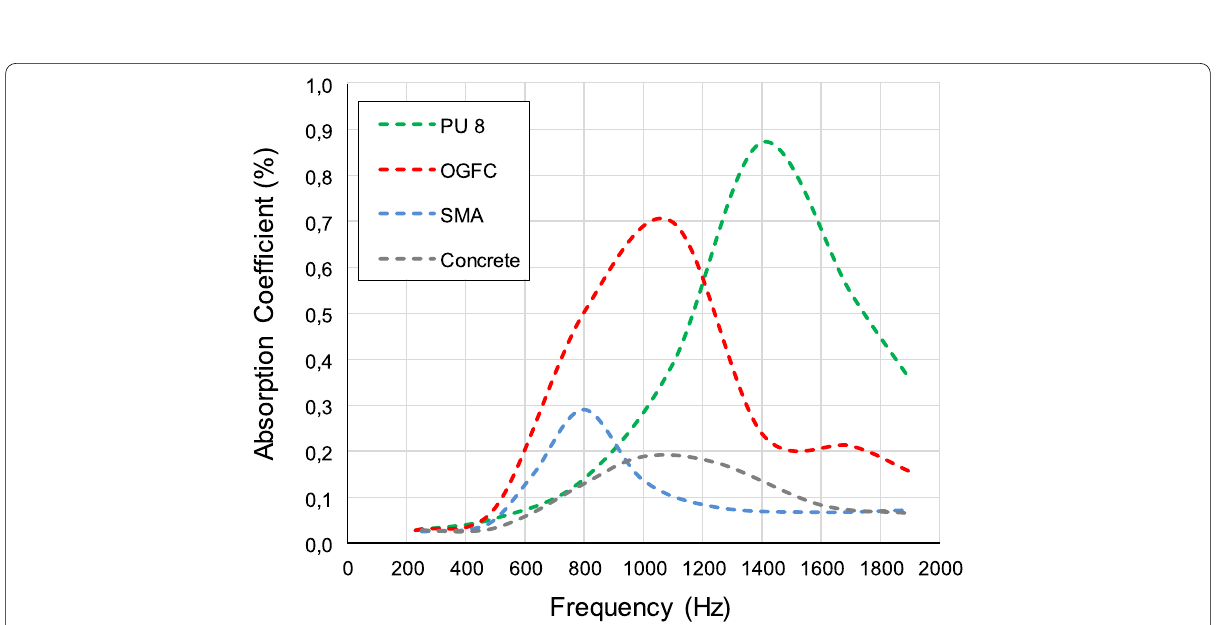
Fig. 6 The comparison of acoustic absorption coefficient between the polyurethane mixture and asphalt mixture